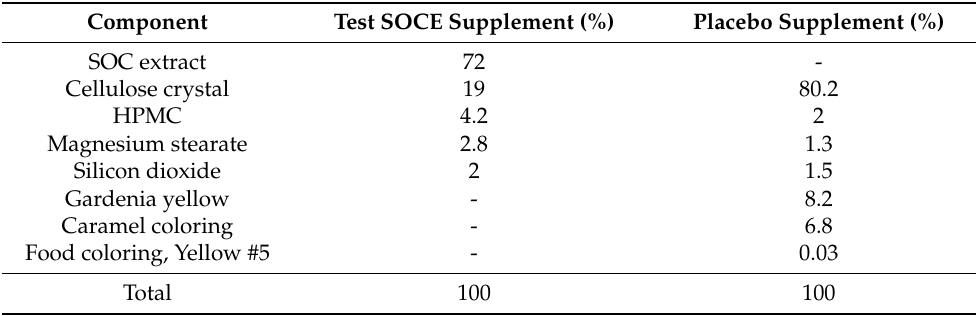
Table 1. Composition of the test products.